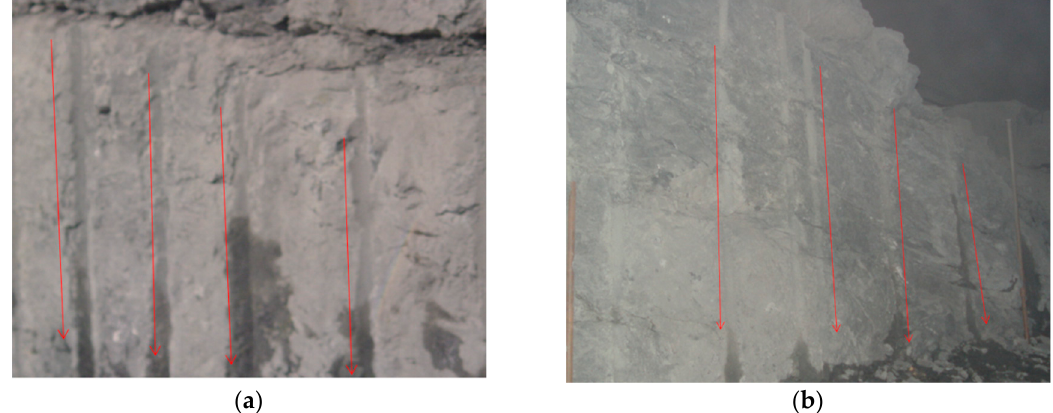
Figure 19. Presplitting surface after presplitting blasting: ( a ) Number T 1 ; ( b ) Number T 2 .